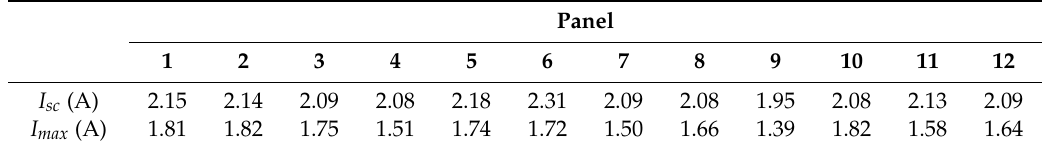
Table 1. Values of short-circuit and maximum aging current calculated for each panel. Panel